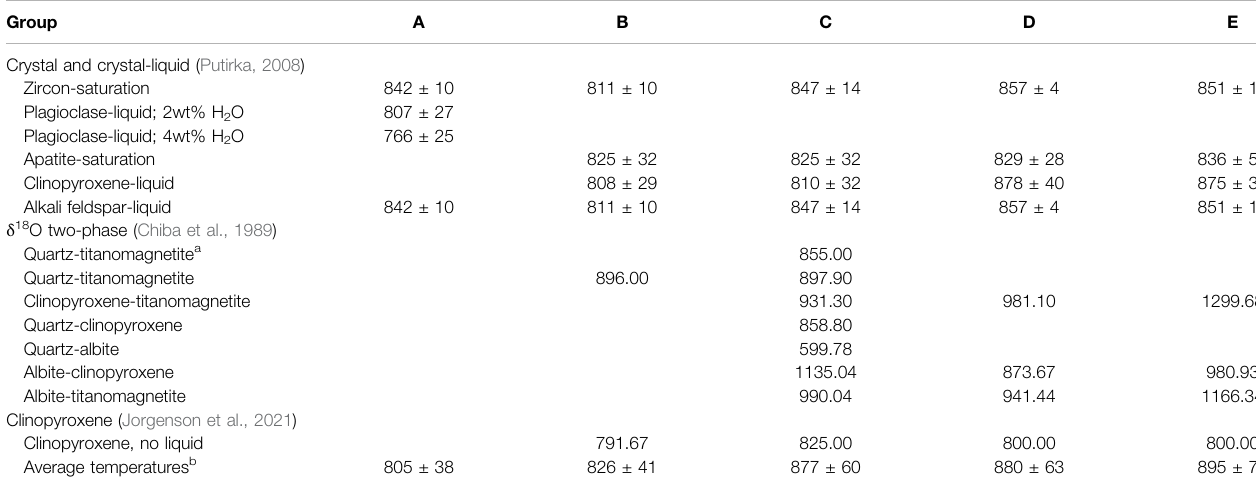
TABLE 3 | Calculated crystal, crystal-liquid, and oxygen isotope temperatures ( ° C).